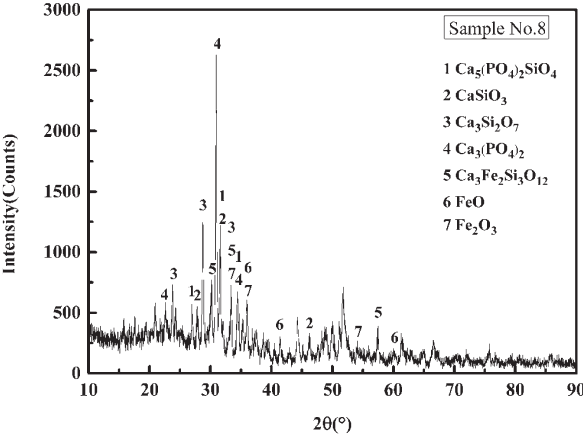
Fig. 6: The results of X-Ray diffraction analysis for sample No. 8